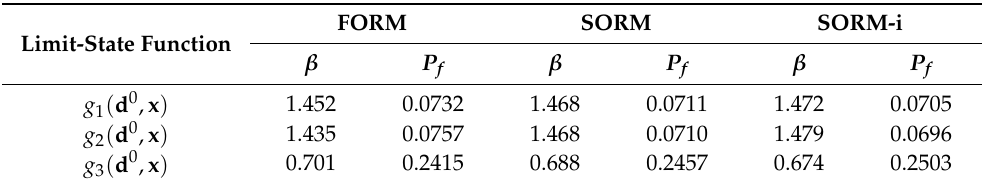
Table 11. Failure probabilities and reliability indices of initial limit-state functions estimated using